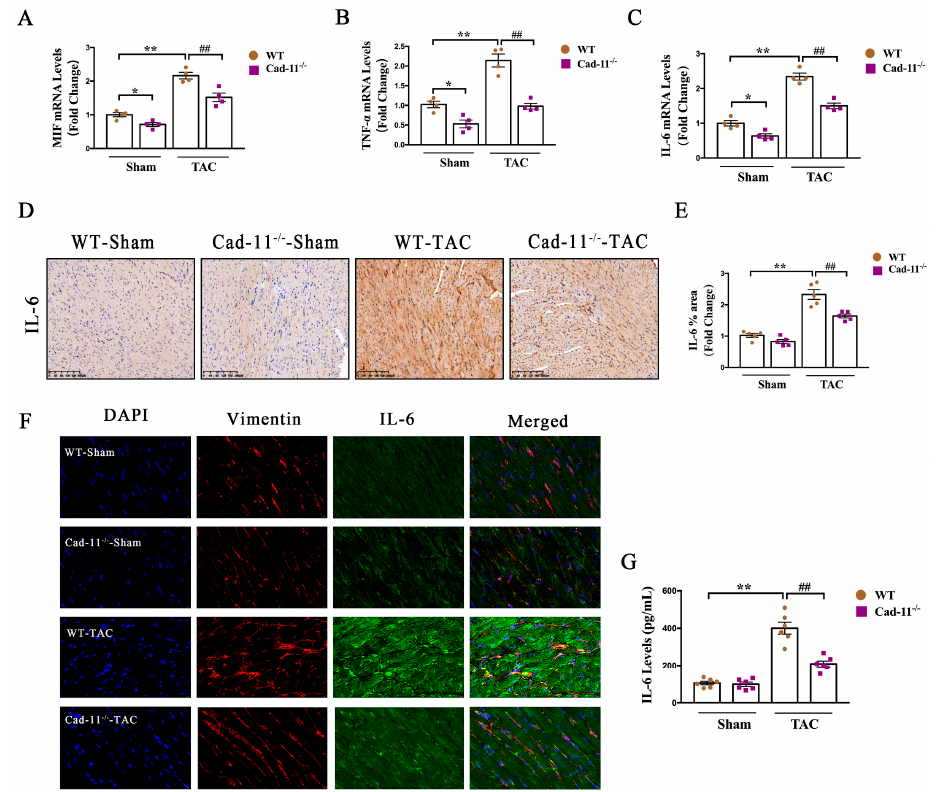
Figure 4. Loss of Cad-11 decreased IL-6 production in transverse aortic constriction (TAC) mice. ( A – C ) Relative mRNA levels of inflammation-related factors MIF, TNF- α , and IL-6 in samples obtained from WT and Cad-11 − / − mice LV tissues following 4 weeks of sham or TAC operation ( n = 4 in each group). ( D , E ) Representative immunohistochemical staining of IL-6 using IL-6 antibody. Quantification of IL-6 expression in the LV of heart sections from the indicated mouse groups ( n = 5 in each group) were summarized in ( E ). ( F ) Representative images of immunofluorescent staining of heart sections with anti-Vimentin (red), anti-IL-6 (green), and DAPI (blue) from WT-Sham, WT-TAC, Cad-11 − / − -sham, and Cad-11 − / − -TAC mice. ( G ) Average IL-6 concentrations (determined by ELISA) in serum in the indicated mouse groups. ( n = 6 in each group). Data were presented as mean ± SEM, * p < 0.05, ** p < 0.01 vs. WT-Sham group. ## p < 0.01 vs. WT-TAC group.